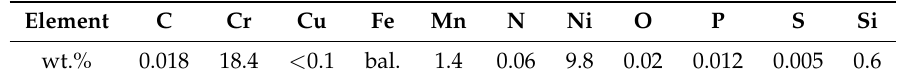
Table 1. Chemical composition of AISI 304L stainless steel powder particles in weight percentage.